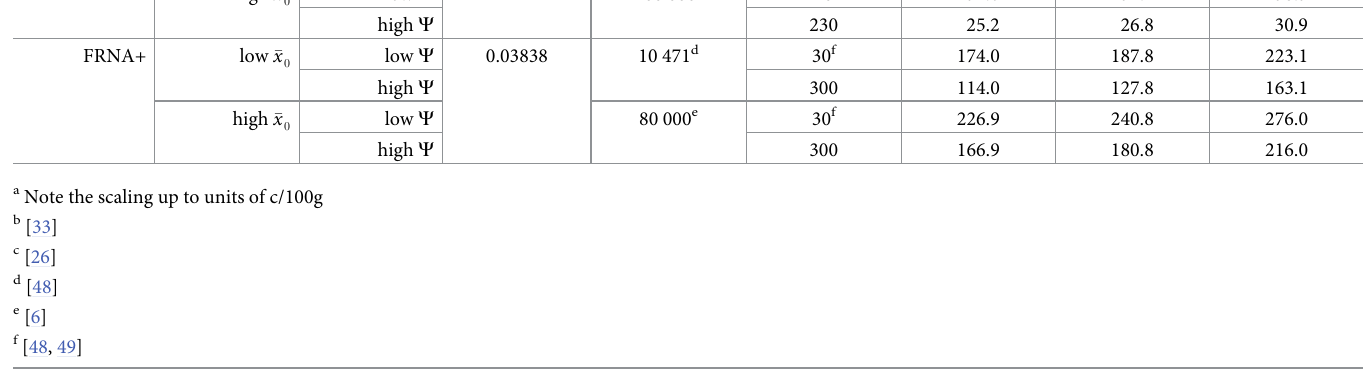
Table 4. Sensitivity of minimum depuration times ( T WCV ) to parameters (cid:22) x